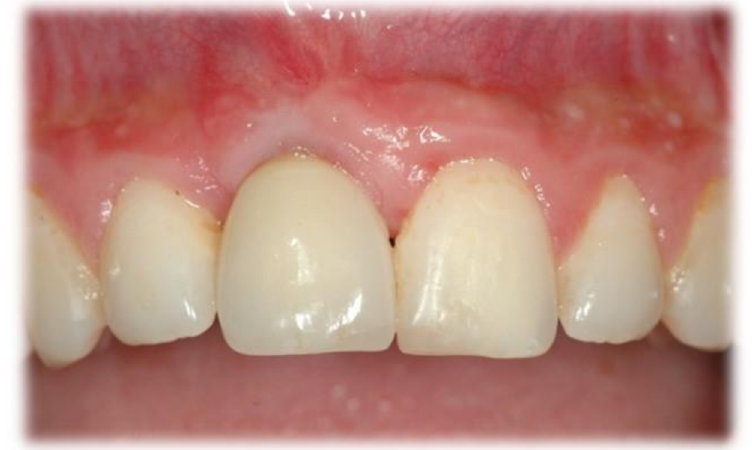
Figure 5. Tooth number 11, 49-month follow-up: PES = 7, WES =